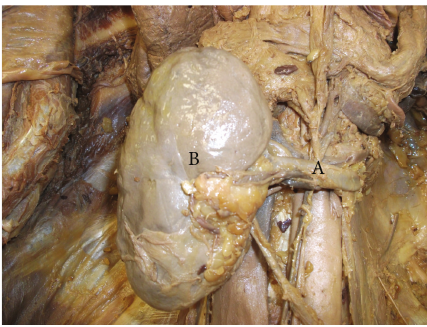
Figure 2: Left renal hilum (posterior view). (A) Left posterior segmental renal artery, (B) left kidney.